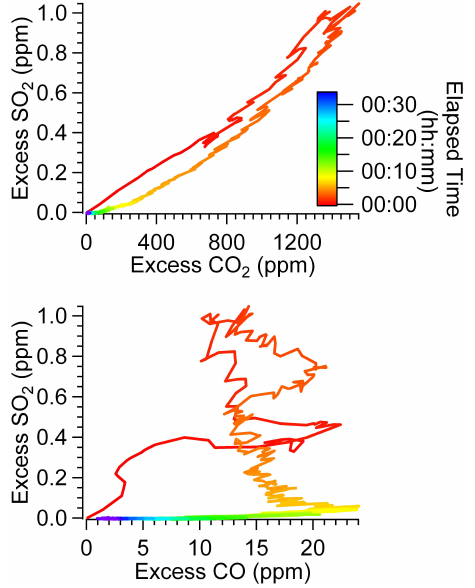
Fig. 10. Evolution of excess SO 2 as a function of excess CO 2 (top graph) and as a function of CO (bottom graph) for a typical fire.